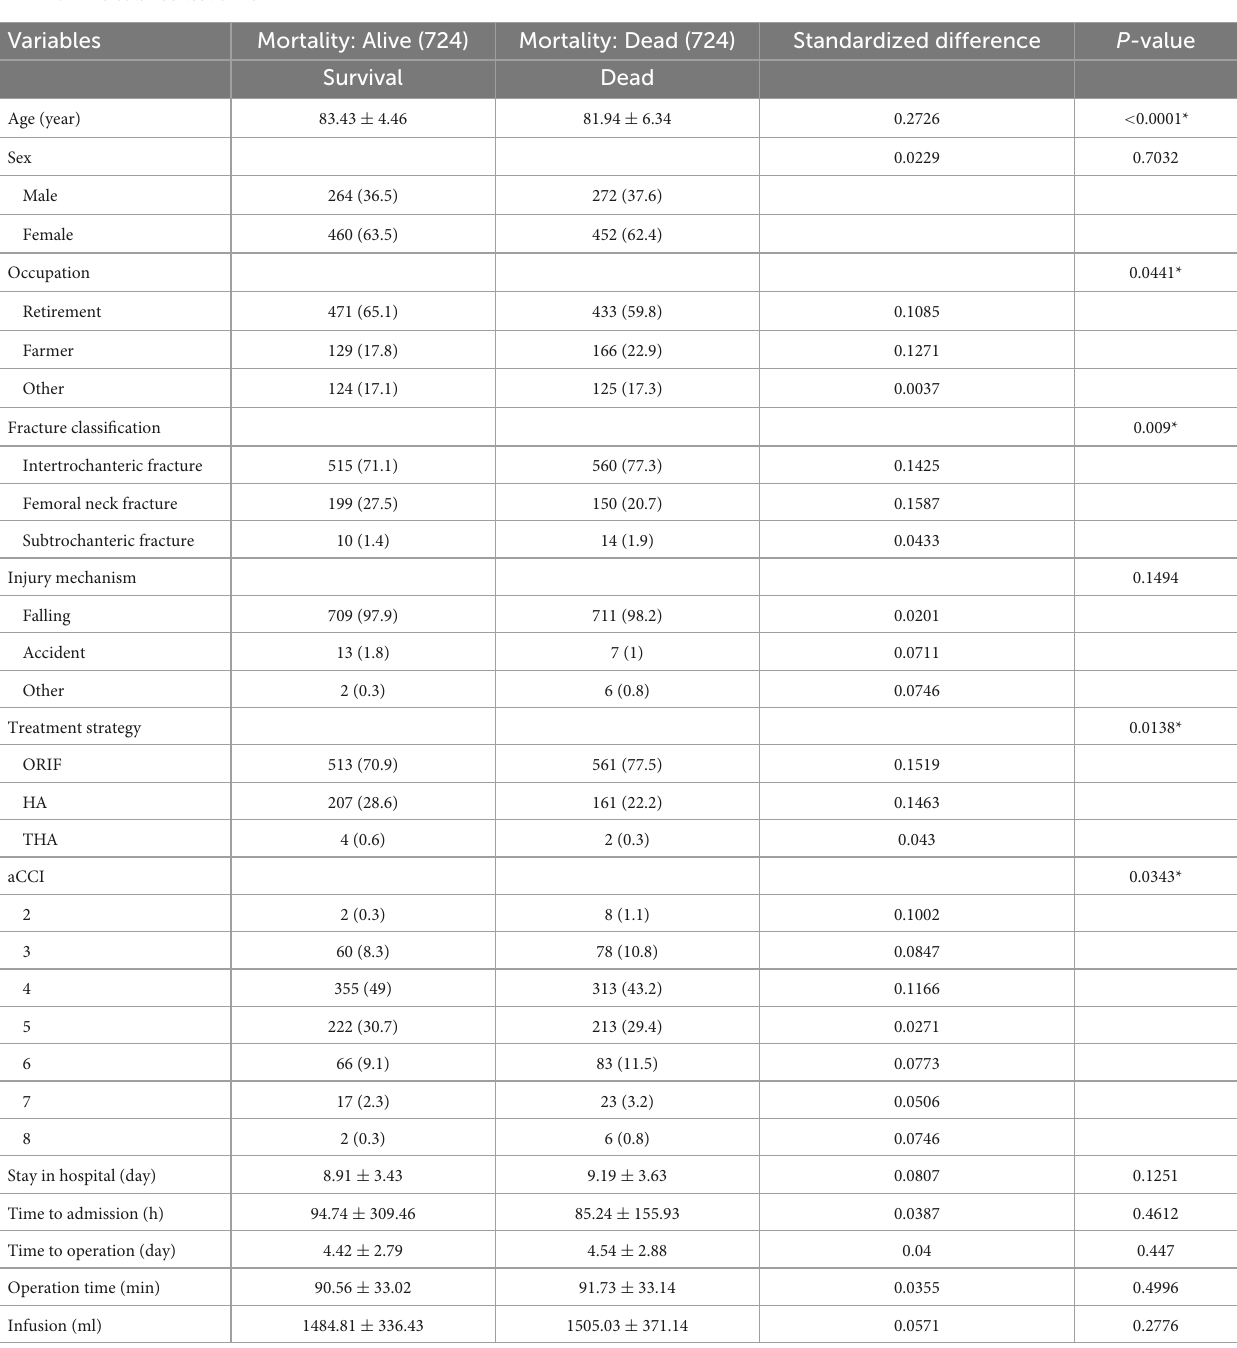
TABLE 6 The balance test of PSM.